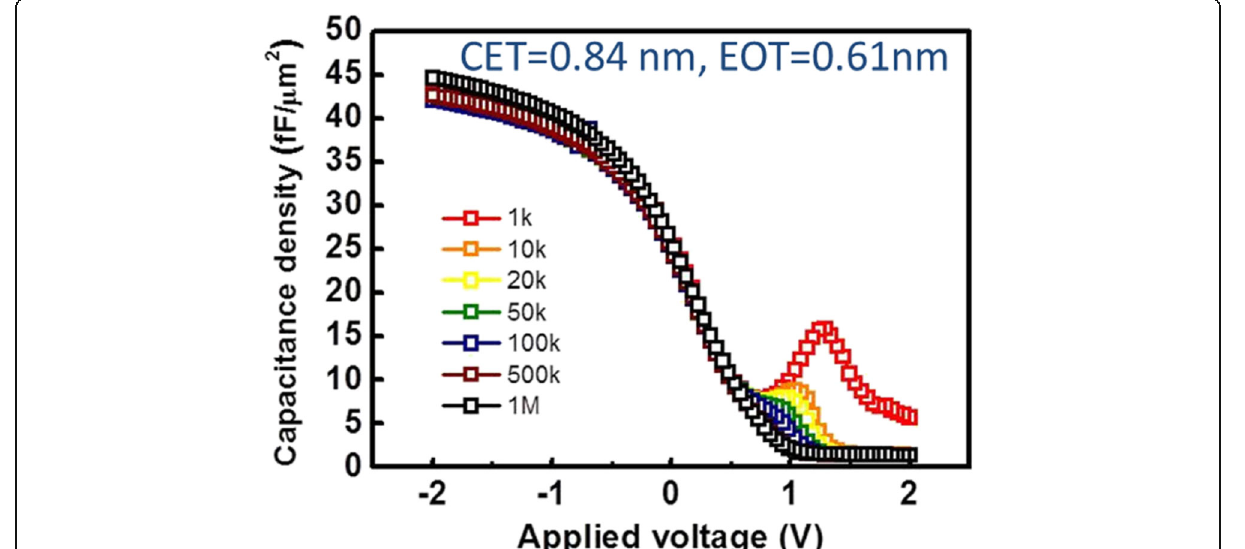
Fig. 3 C-V characteristics of the TiN/ZrO 2 /Ge MISCAPs with EOT ~ 0.6